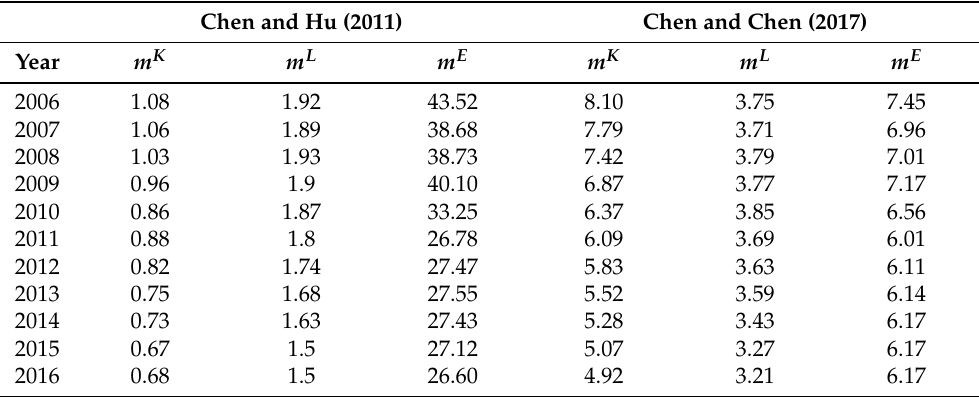
Table 2. Comparison of the degree of misallocation of various factors (%). Chen and Hu